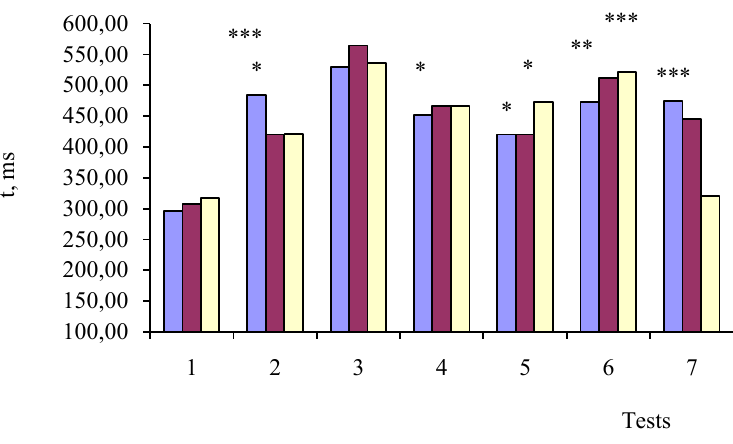
Fig. 2. Latent response time of elite athletes, specializing in speed climbing (n=10), climbing on complexity (n=10) and mountaineers (n=6):